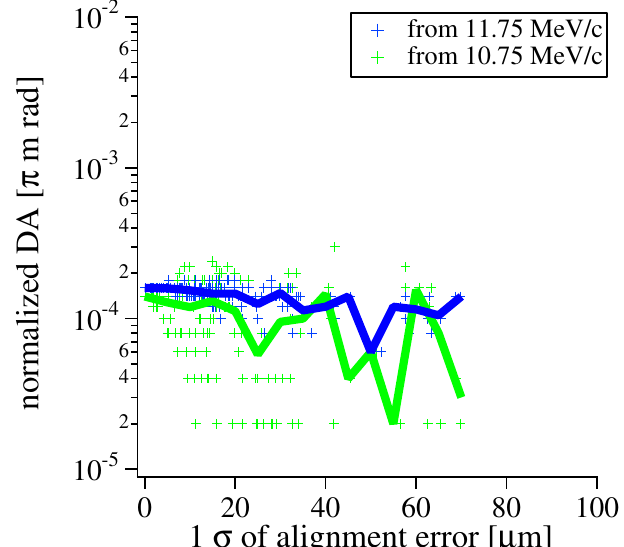
FIG. 7. (Color) Initial amplitude which was not accelerated to the final momentum. Lattice has chromaticity correction with sextupole and octupole. It takes 1000 turns to finish the whole cycle. Green markers show the case when acceleration started from 10 : 75 MeV =c . Blue markers show the case when accel- eration started from 11 : 75 MeV =c to avoid Qy ¼ 5 . Solid curves show the average among the nearby points.